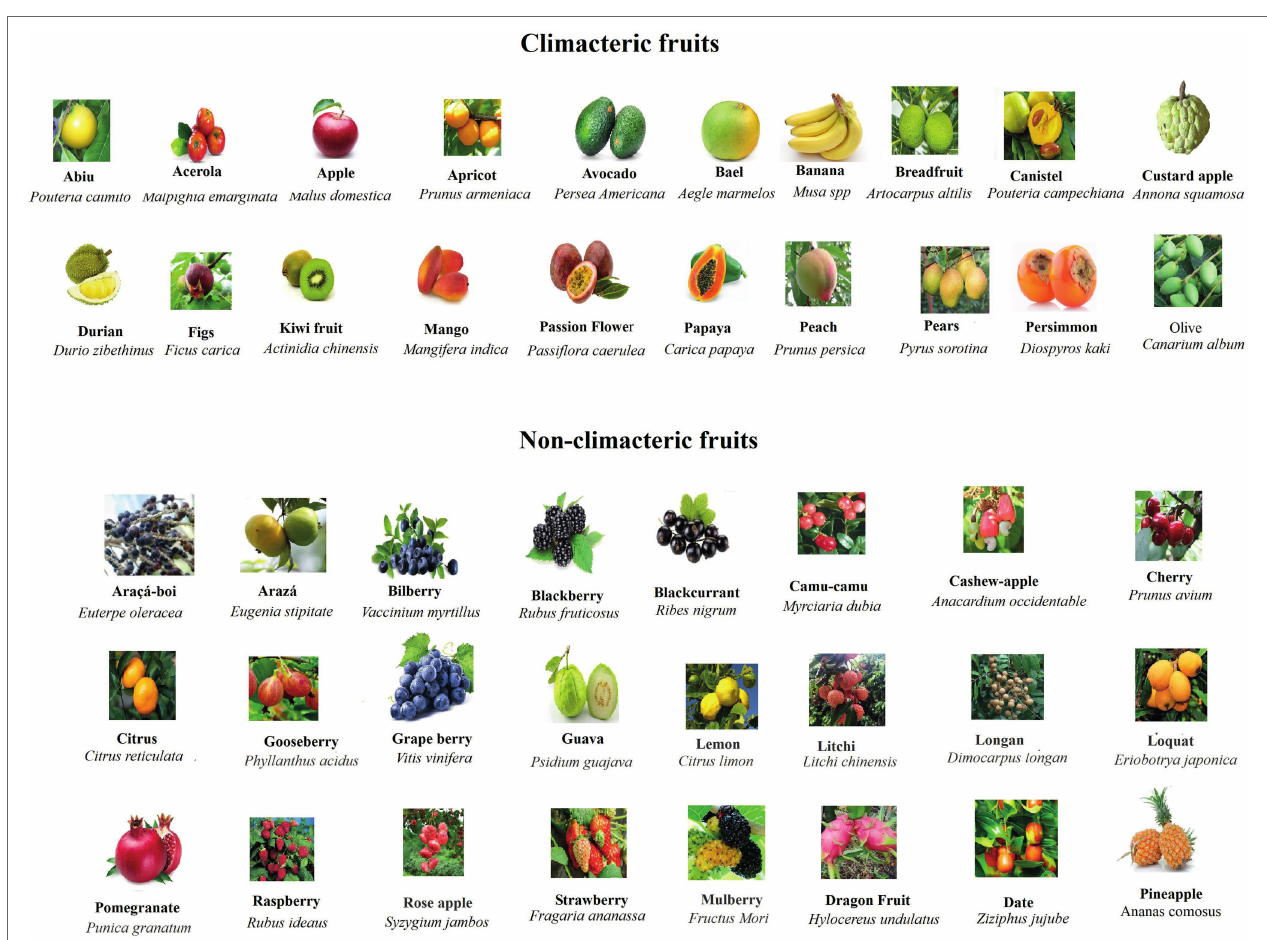
FIGURE 1 | Pictures of typical CL and NC fruits showing the appearance features of different fruits. Note that NC fruits are commonly more colorful and their sizes are commonly smaller in comparison with CL